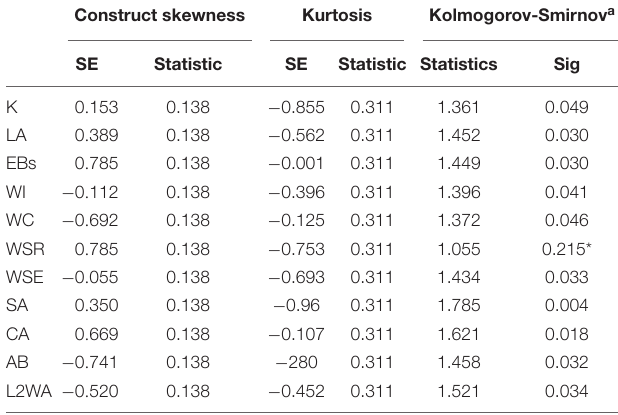
TABLE 3 | Skewness, kurtosis, and normality test for different variables.